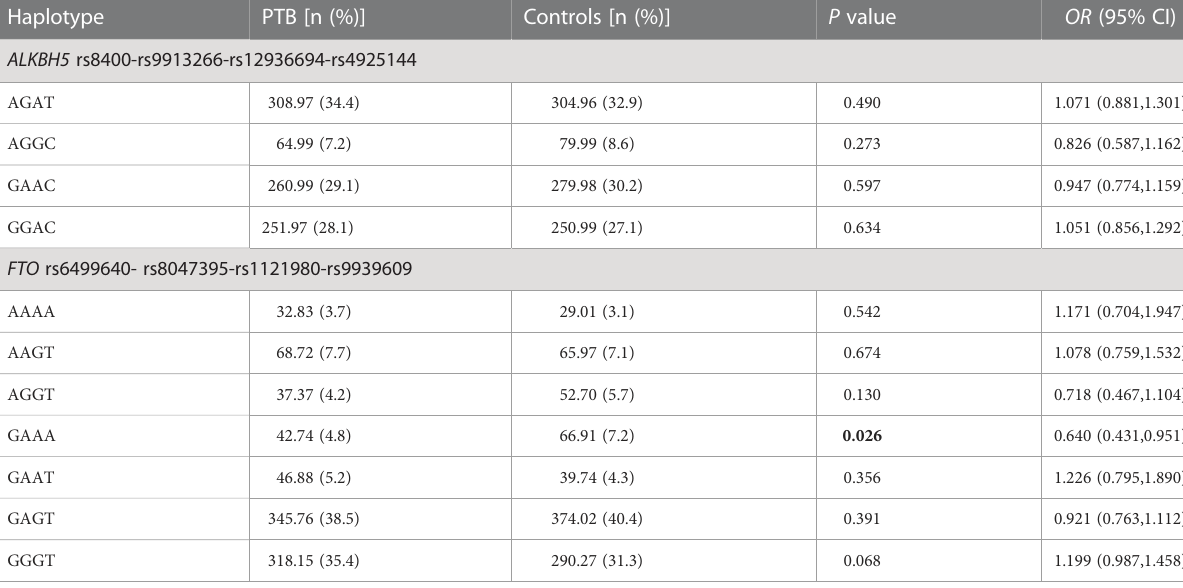
TABLE 2 Haplotype analysis of ALKBH5 , FTO genes in PTB patients and controls.